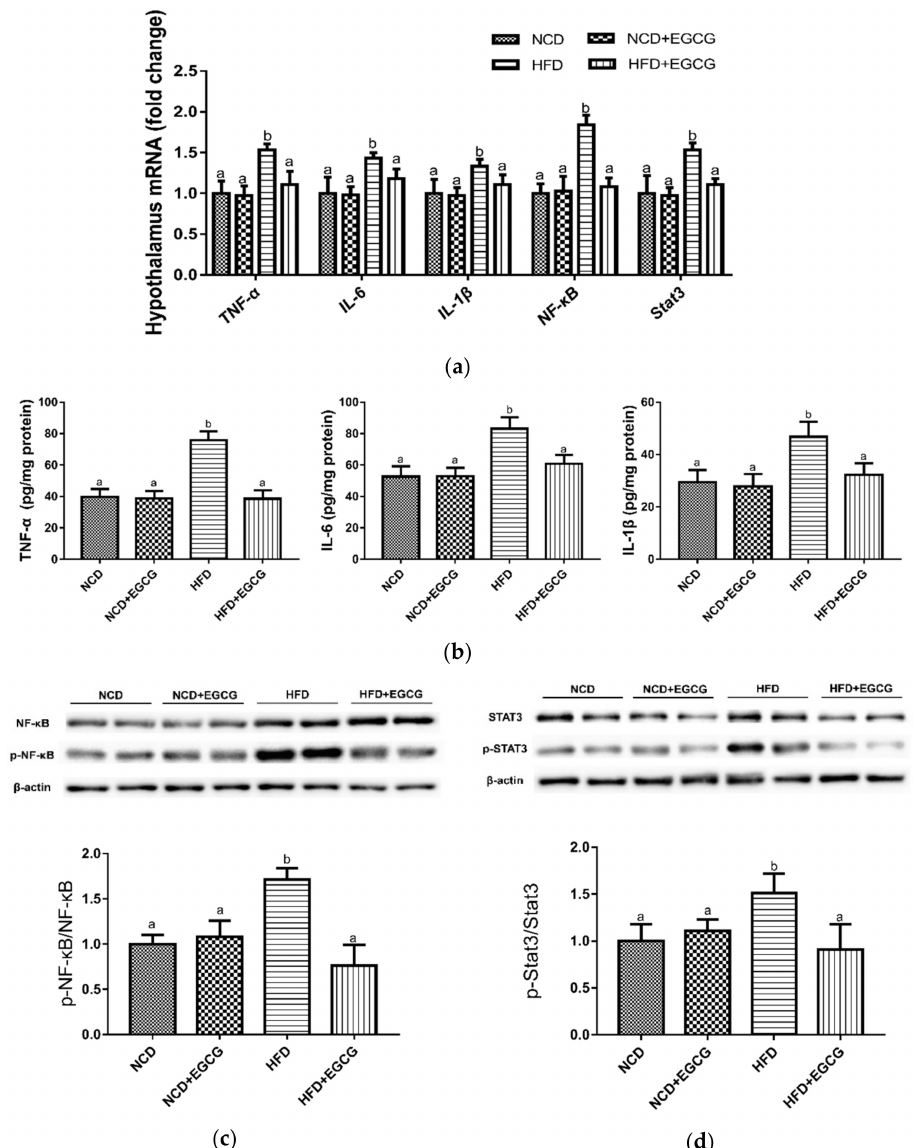
Figure 3. Effect of EGCG on hypothalamic inflammation. ( a ) mRNA expressions of TNF- α , IL-6 , IL-1 β , NF- κ B and Stat3 in the hypothalamus; ( b ) Concentrations of TNF- α , IL-6, IL-1 β in the hypothalamus; ( c , d ) Immunoblot analysis of NF- κ B and Stat3 phosphorylation levels in the hypothalamus. Data are the means ± SD of three independent experiments performed in triplicate ( n = 3). Mean values with different letters (a and b) are significantly different ( p <